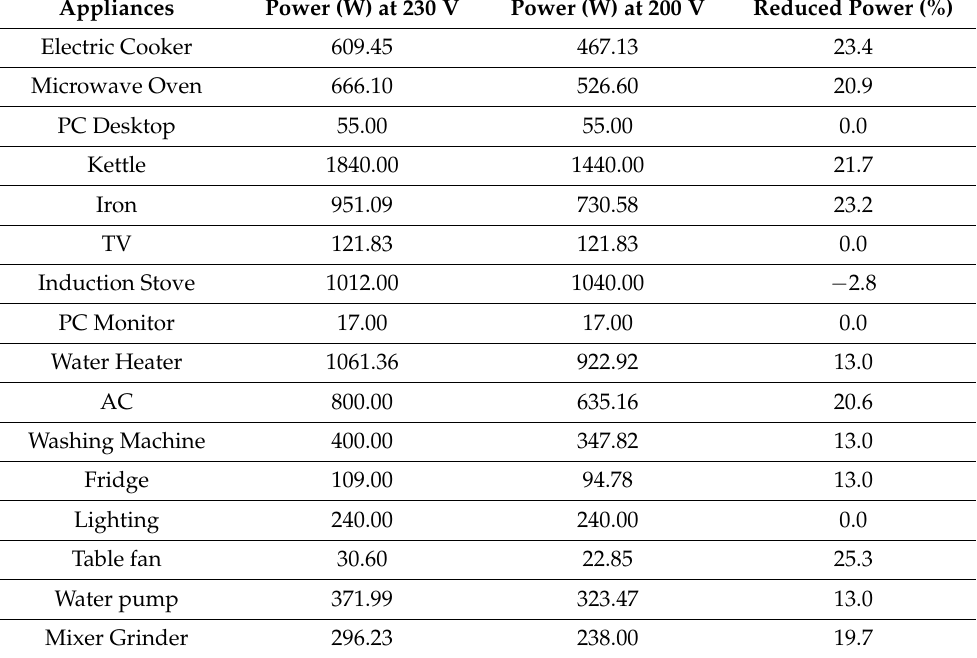
Table 1. Experimental results of the CVR effect on different demand types [22].